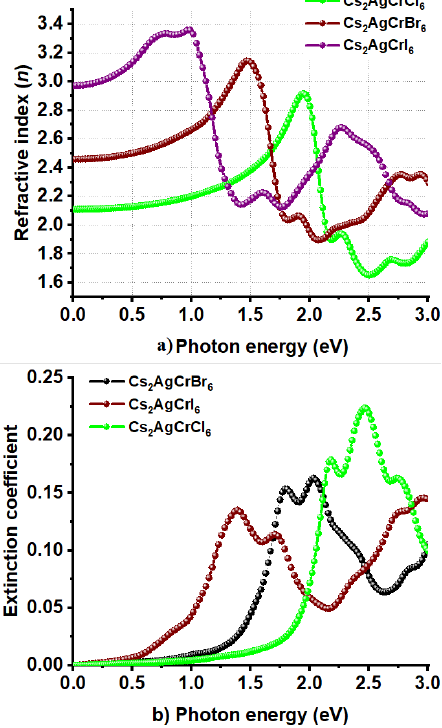
Figure 9. Behavior of the ( a ) real and ( b ) imaginary part of complex refractive index against the photon energy for Cs 2 AgCrX 6 (X = Cl, Br, I).